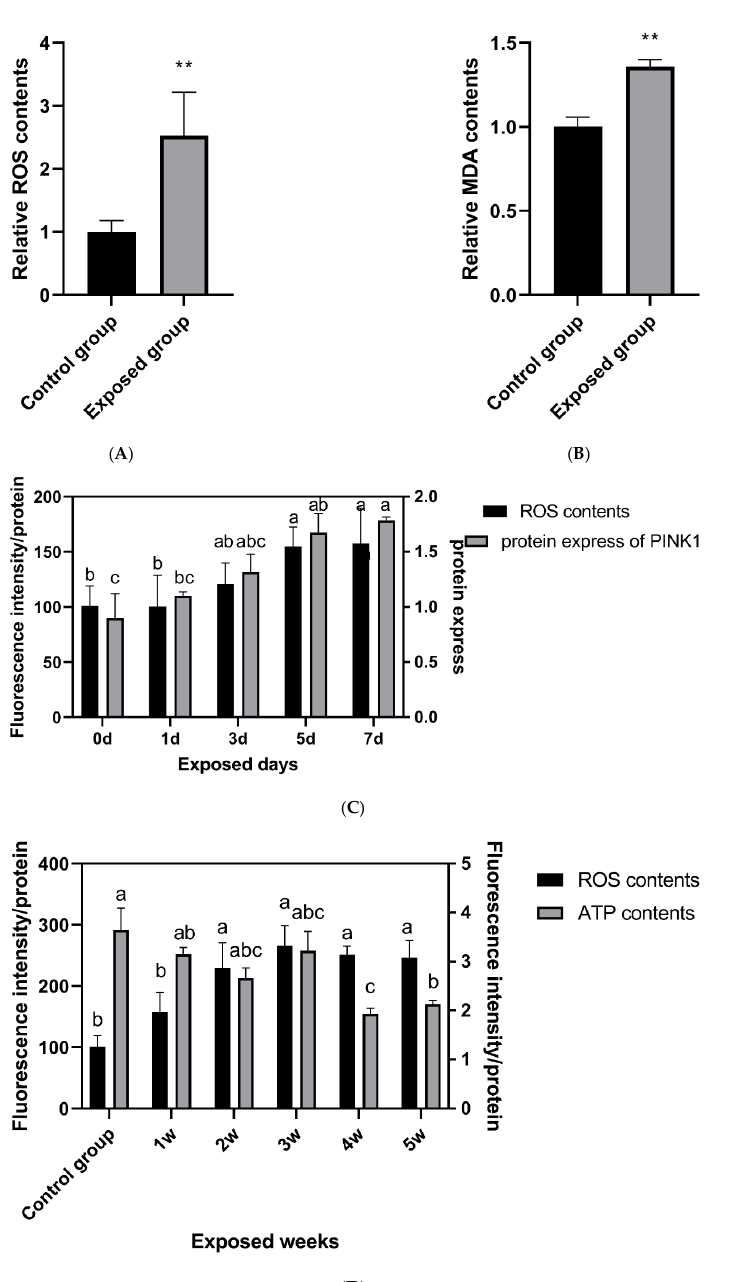
Figure 5. Oxidative levels in testicular tissue and relationship between mitochondrial damage and oxidation. ( A ) ROS level; ( B ) MDA level; ( C ) Mitochondrial structural damage and oxidation; ( D ) Mitochondrial function damage and oxidation. The data are expressed as the mean ± SD (n = 8) and analyzed by dependent sample t -test or ANOVA following the Turkey’s multiple comparisons test. Note: ** p < 0.01 indicates a statistically significant difference from the control. Lowercase letters are completely different, indicating significant difference ( p < 0.05); any of the same lowercase letters means insignificant difference ( p > 0.05).